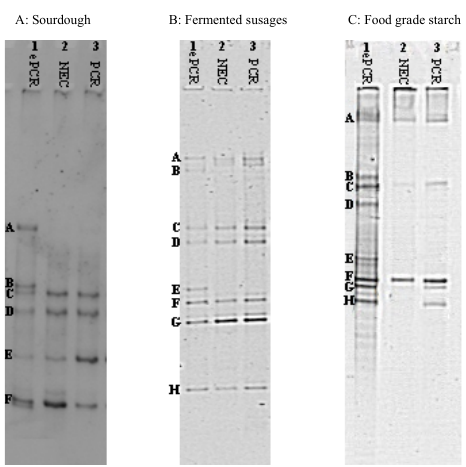
Figure 2. DGGE profiles of PCR amplicons obtained from DNA extracted directly from the food samples. Panel A: sourdough; panel B: fermented sausage; panel C: Food-grade starch; Lane 1, ePCR product; lane 2, non-emulsified PCR product; lane 3, conventional PCR product. Identification of bands is reported in Table